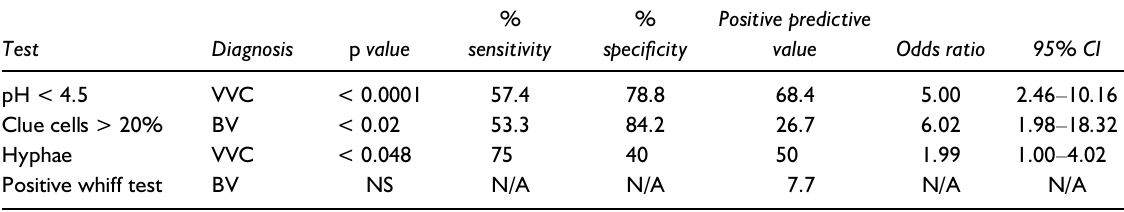
Table 6 Reliability of diagnostic